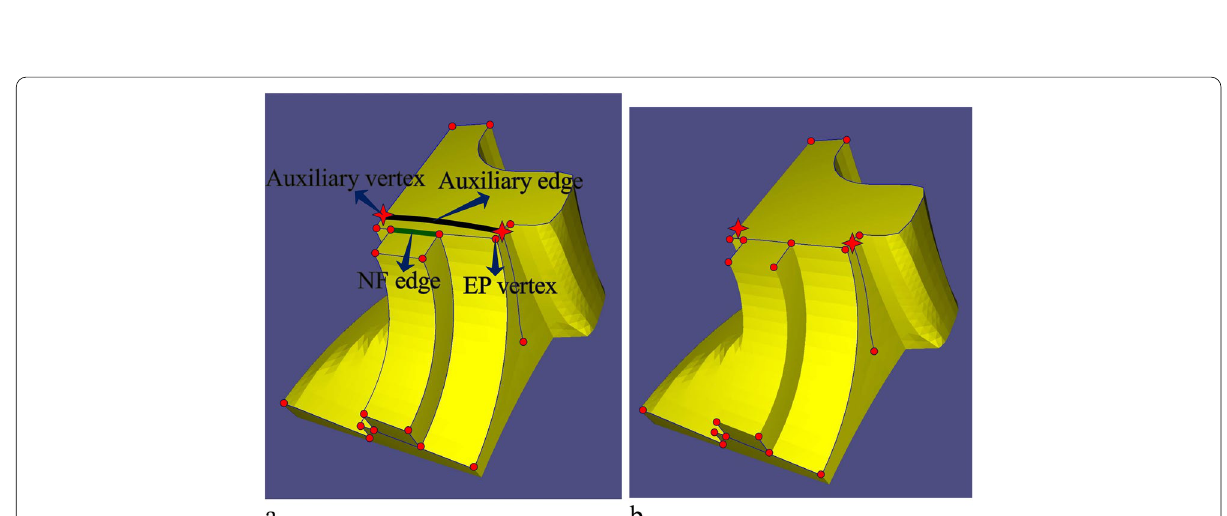
Fig. 9 Information of connected graph and its MST. a Weighted graph of the mesh; b MST of connected graph